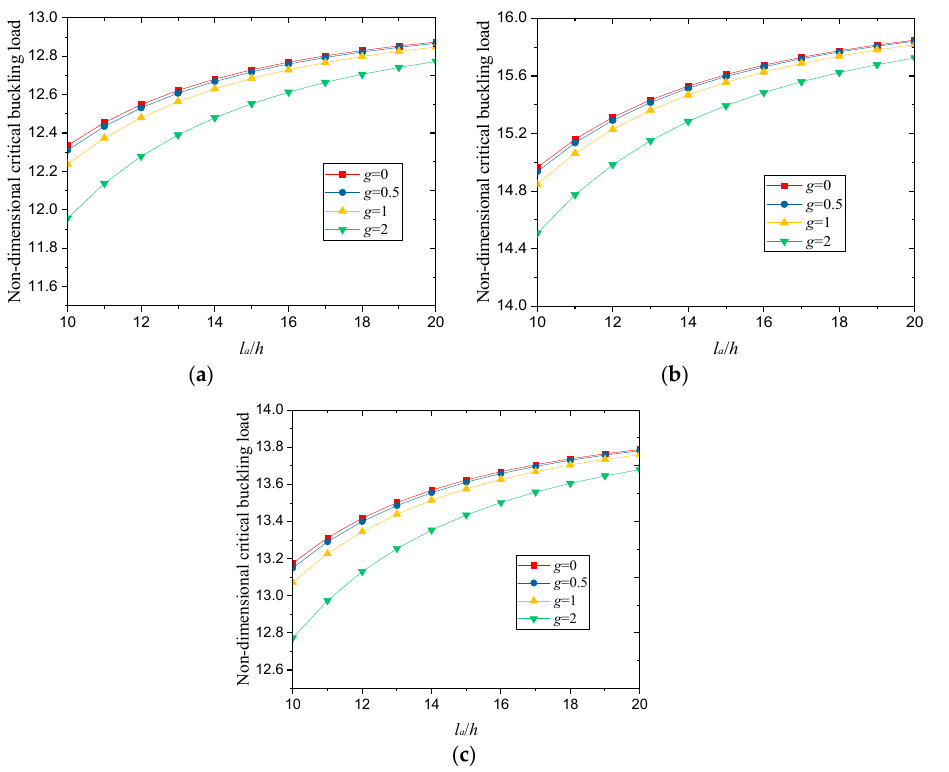
Figure 7. Variation of non-dimensional critical buckling load with a length-to-thickness ratio of square FG nanoporous nanoplate ( m = n = 1, h = 5 nm, l a = l b , ζ = 1, λ = 0.5): ( a ) UD, ( b ) NUD1, ( c ) NUD2. In Figure 8, the non-dimensional critical buckling load versus the axial compression ratio ζ is shown. Here, ζ ＞ 0 corresponds to the biaxial compressive loads and ζ = 0 means a uniaxial load. Figure 8 shows that the non-dimensional critical buckling load became smaller and smaller as the axial compression ratio increased.